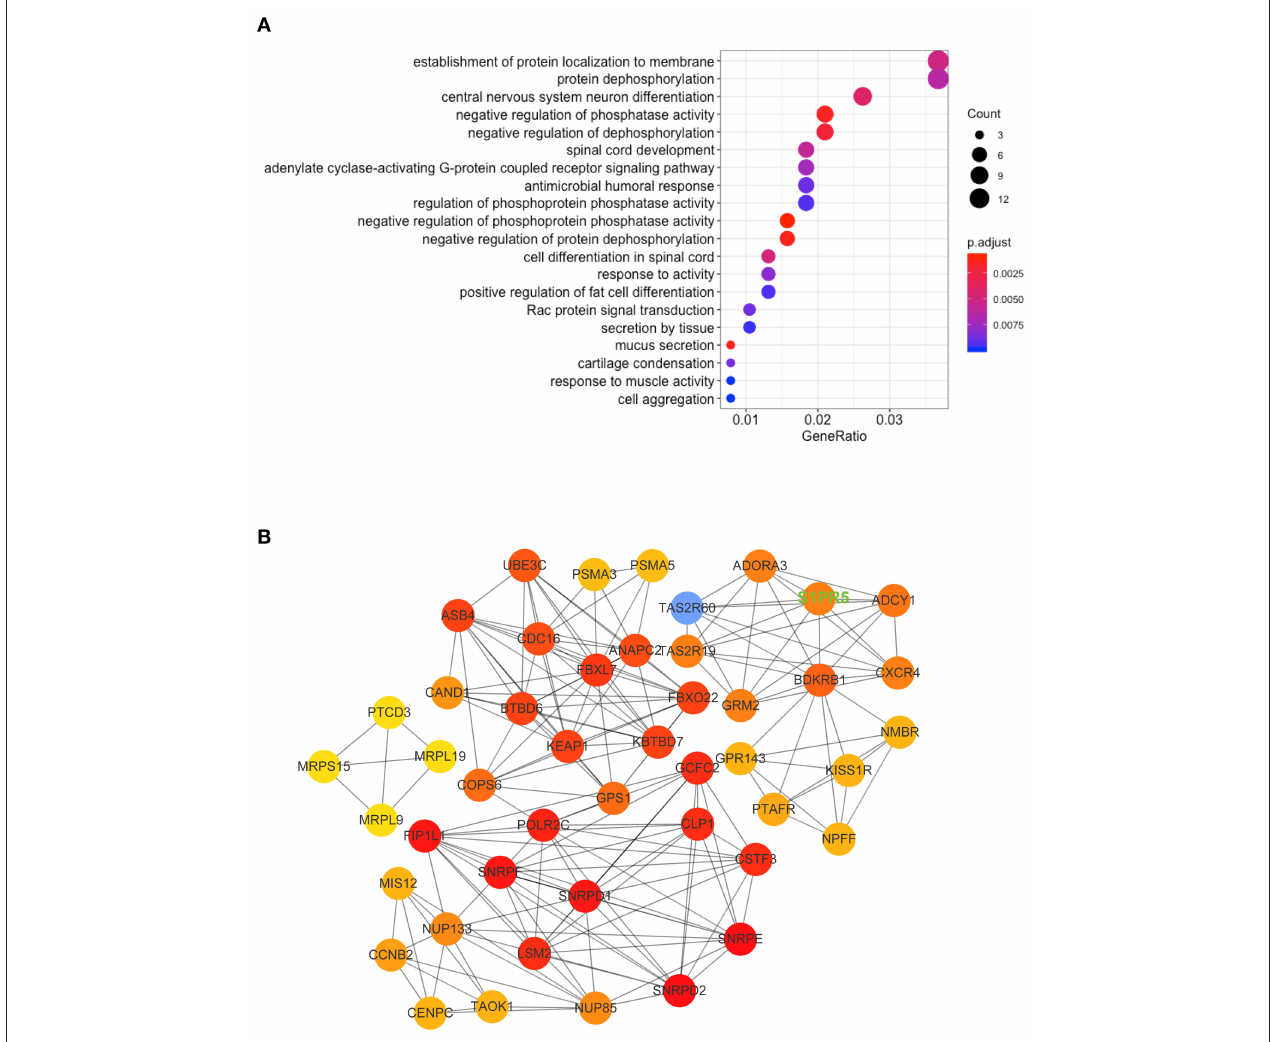
FIGURE 3 | KEGG Pathway and mRNA interaction network analysis based on the validated mRNA candidates. (A) KEGG pathway enrichment analysis of these mRNAs with the 20 highest enrichment scores. (B) mRNA interaction network based on the validated mRNA candidates. Every circle represents a mRNA. The darkness of the color denotes the strength of interaction. The key molecule we studied, S1PR5, has been highlighted in uppercase green fonts on the